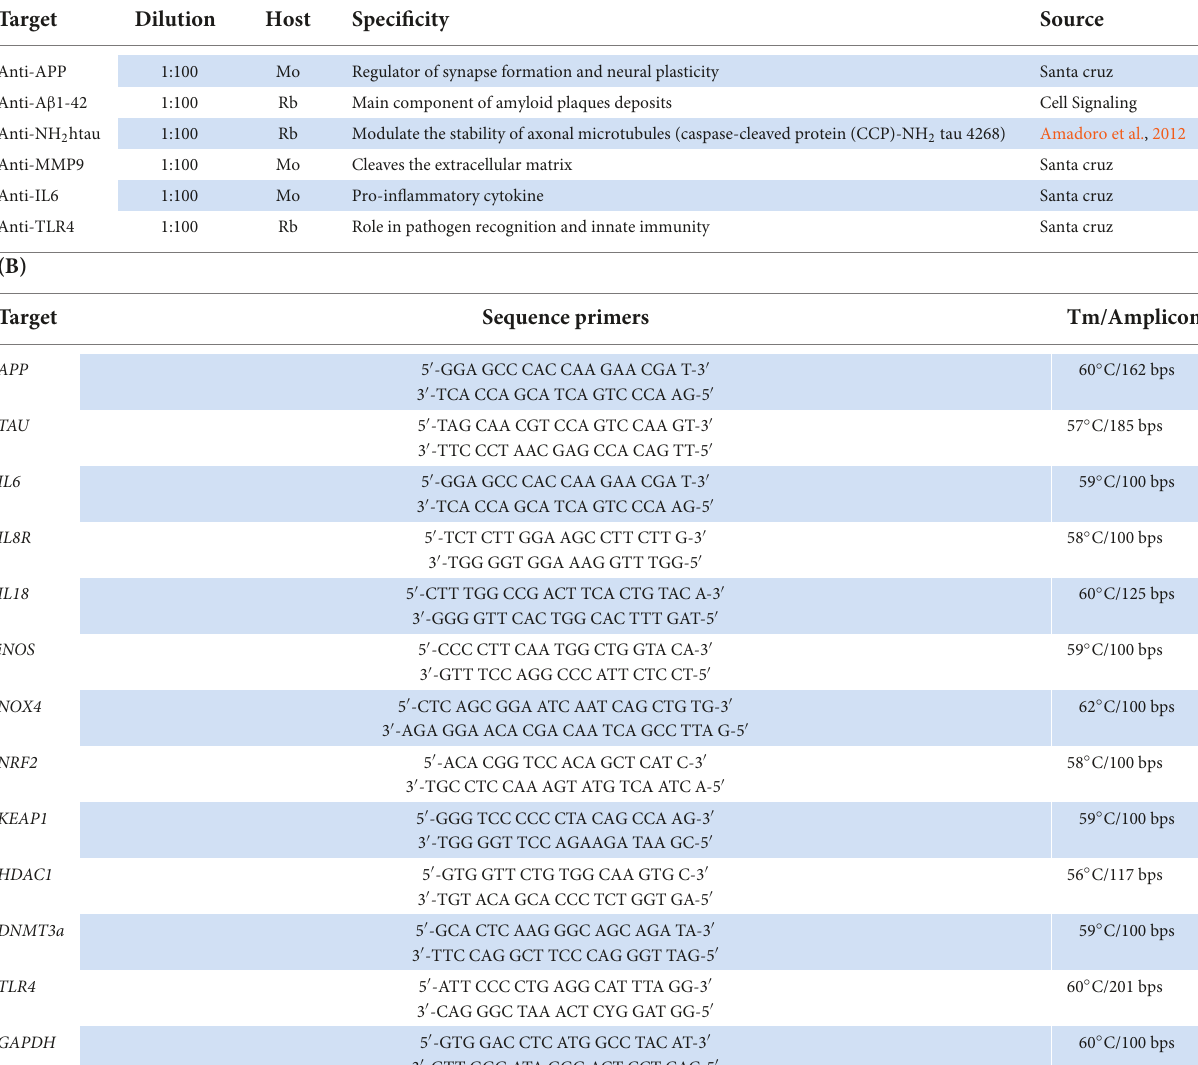
TABLE 1 (A) Immunoprecipitation/immunofluorescence. (B) Molecular